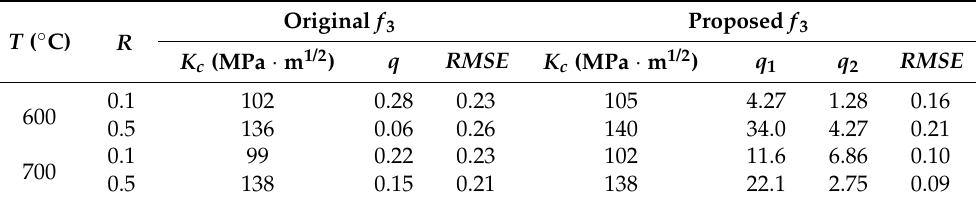
Table 5. Fitting parameters for the original and proposed f 3